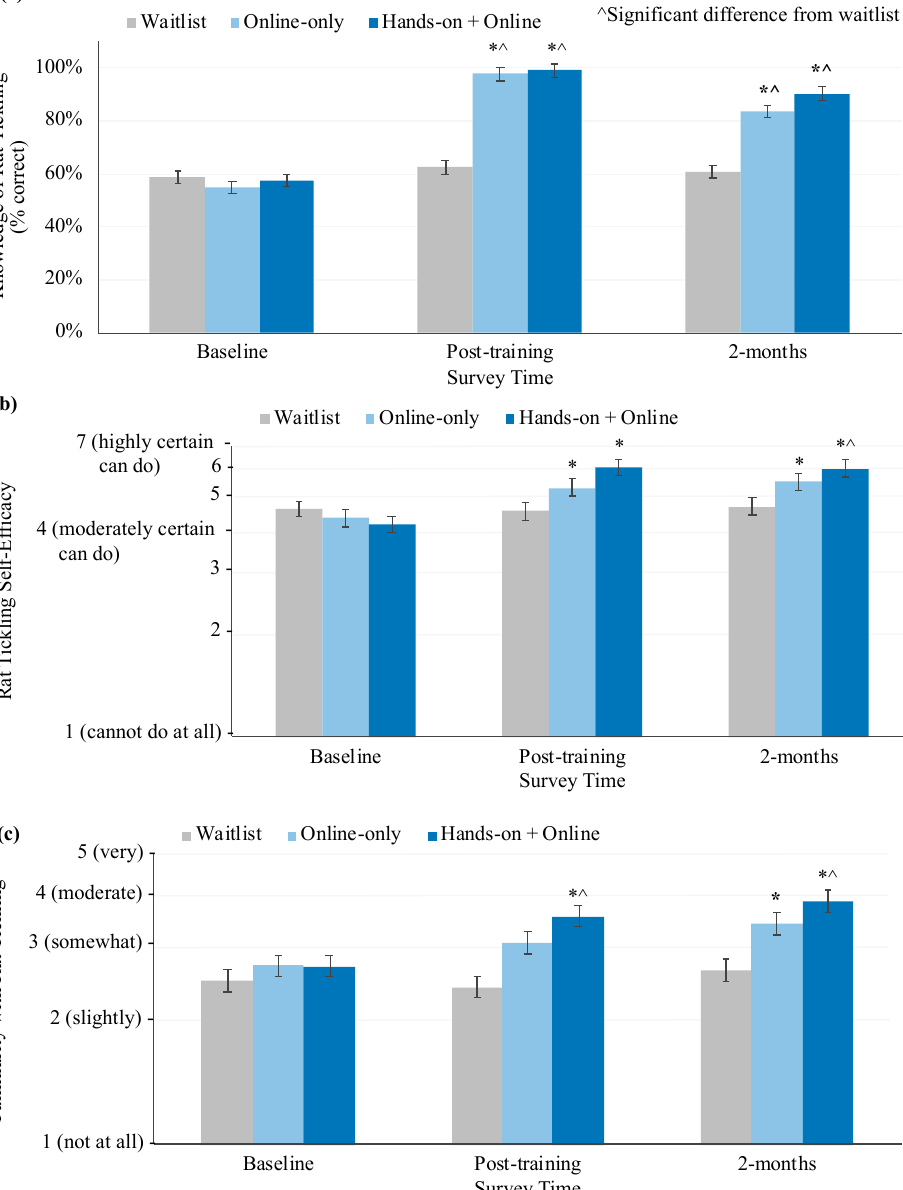
Figure 4. Knowledge, self-efficacy, and familiarity with rat tickling. This figure shows the highest order significant associations from general linear mixed models of ( a ) knowledge, ( b ) self-efficacy, and ( c ) familiarity with rat tickling. Variables were measured via a self-report survey. Models were run controlling for demographic, work, and potential confounding variables. The scales of (b) self-efficacy and (c) familiarity are back transformed from log10. Scales display only the range of possible responses. Data is presented as least squares mean ± standard error of the mean. * indicates a significant difference from baseline within the treatment group. ^ indicates a significant difference from the waitlist within the time point.